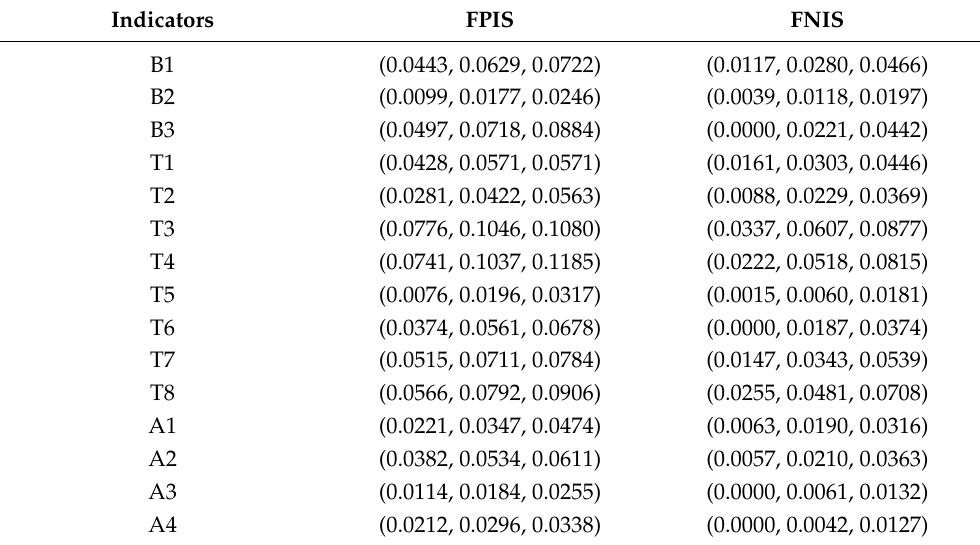
Table 6. The fuzzy positive-ideal solution (FPIS) and fuzzy negative-ideal solution (FNIS). Indicators FPIS FNIS